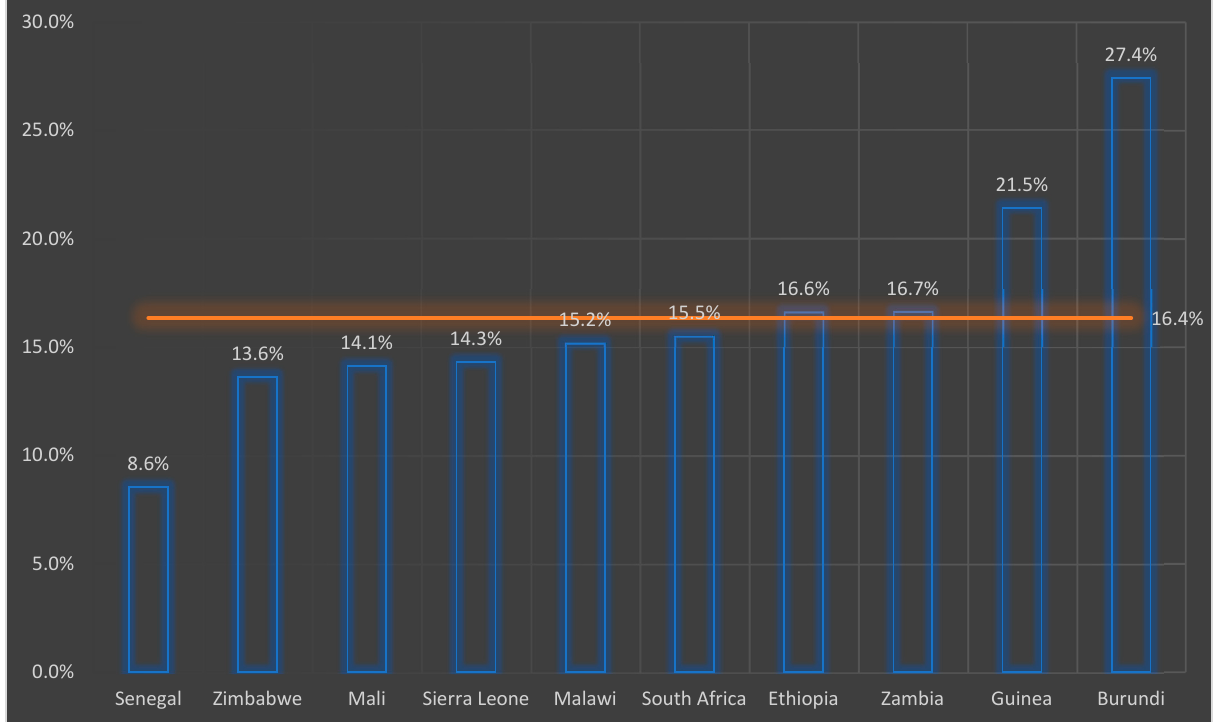
Figure 2. Double burden of malnutrition by country. Table 7. Estimated prevalence of DBM among children by socio-economic status (SES) quintile.